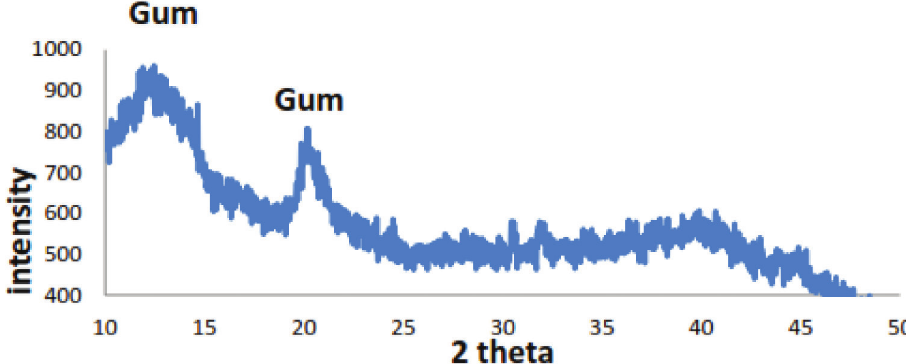
Figure 6: The powder XRD (X-ray diffraction) pattern of the Pd-NPs/guar gum catalyst before the